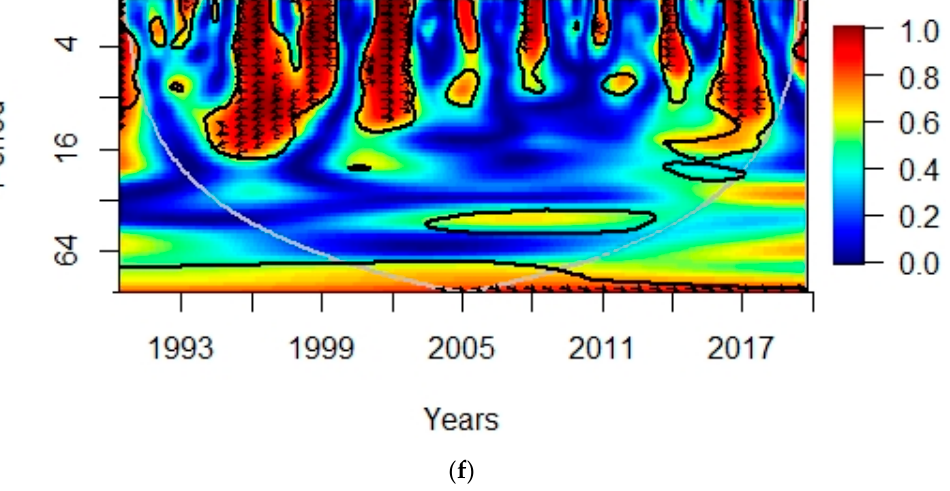
Figure 1. Shows the wavelet coherence between CO 2 e and ( a ) financial institutional deepening (FID), ( b ) GDP, ( c ) import (IMP), ( d ) export (EXP), ( e ) REC, and ( f ) technology innovation (TI) for G-10 countries from 1990 to 2020.